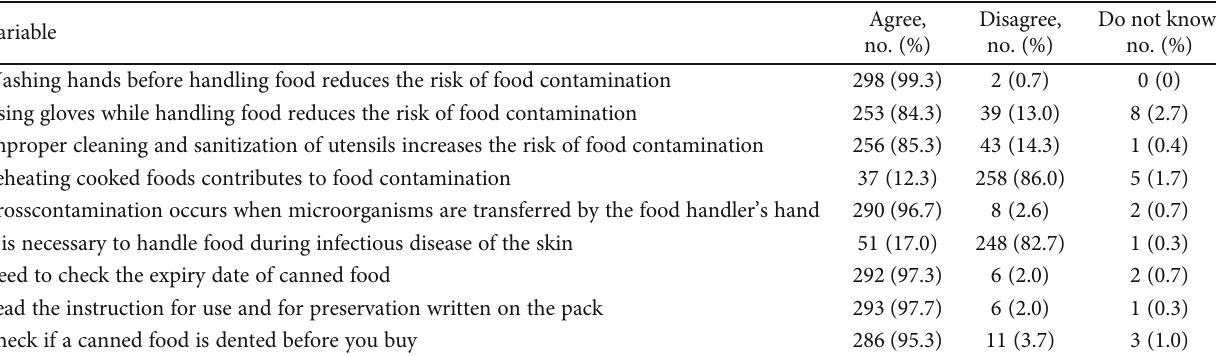
Table 2: Food handling practices among the respondents.